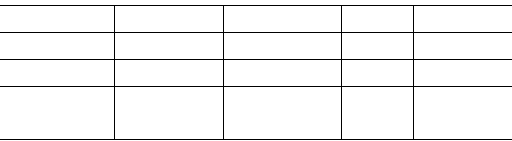
Patients who were on MHD, in seven patients, kt/ v was more than 1 (1 to 1.5) while 3 patients had kt/v below 1 signifying inadequacy of HD treatment. Almost all patients had inter-current ailment while on MHD. Four patients were infected with tuberculosis, two developed respiratory tract infections, whereas infective endocarditis, disseminated herpes zoster and gangrenous change of a-v fistula occurred in one